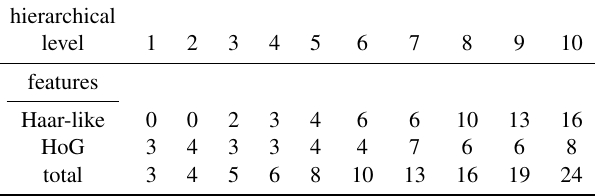
Table 3: Distribution of features used in the hierarchical detector